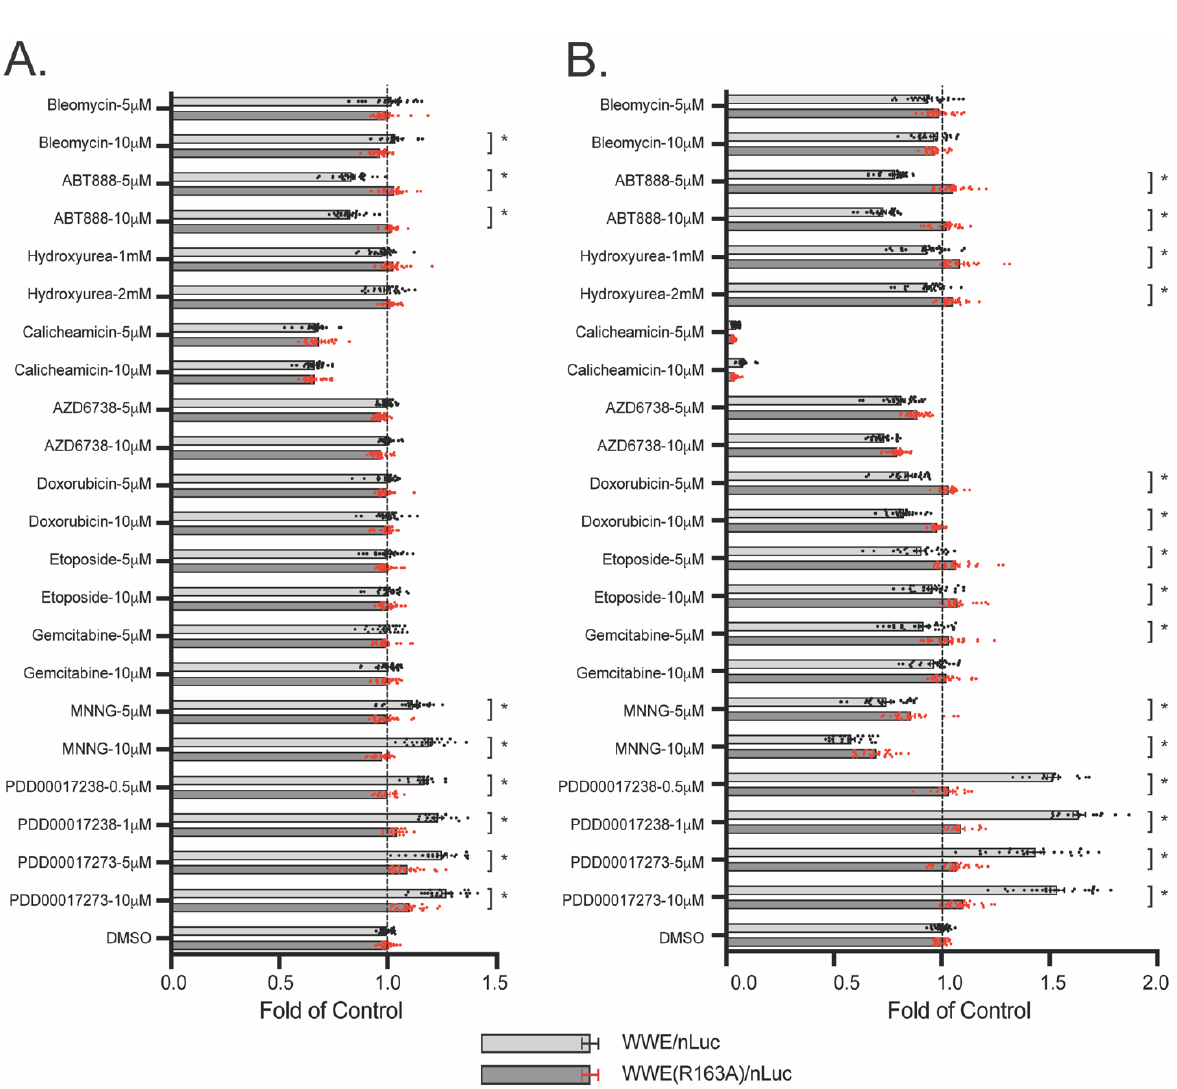
Figure 7. Genotoxin screening for PARylation using the WWE split luciferase assay. U2OS cells expressing WWE-nLuc (or WWE(R163A)-nLuc) and WWE-cLuc were treated with individual com- pounds at the specified concentration. The vertical dotted line denotes a DMSO-normalized value. ( A ) PAR formation following 30 min of compound exposure. Values are normalized to untreated controls. ( B ) PAR formation following 6 h of compound exposure. For ( A , B ), each dot represents a single plate reading, with mean and SEM (red bars) shown; N ≥ 8 reads. * p < 0.05 using a two-sample t -test in comparison between WWE-nLuc and WWE(R163A)-nLuc for each test condition.